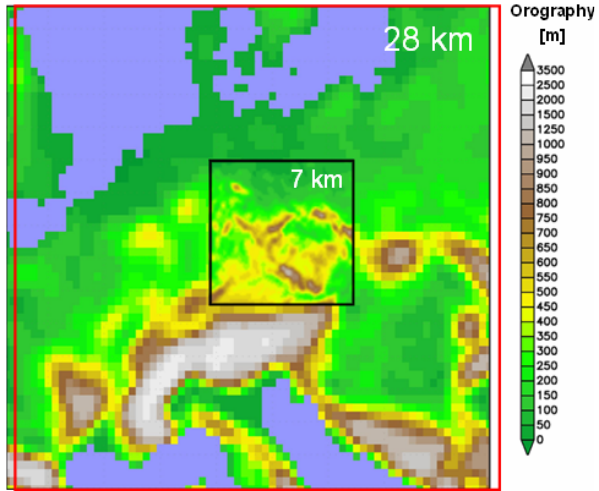
Fig. 1. The model domains. The coarse grid covers central Europe, and the catchment area is nested into the coarse grid with a higher resolution. The red box denotes a shifting of the synoptic weather conditions of two grid boxes (about 56km) to the